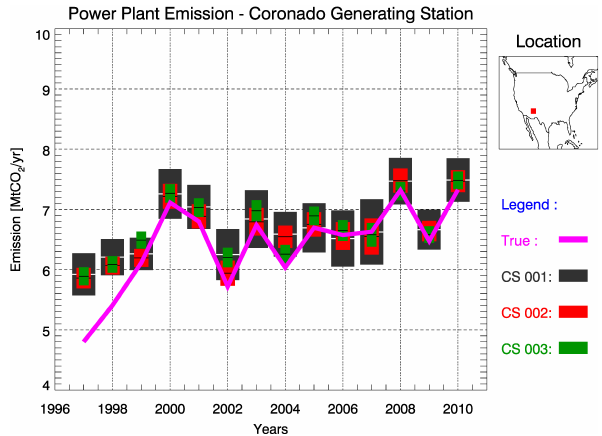
Fig. 13. Same as Fig. 11 for the Coronado generating station in Arizona,